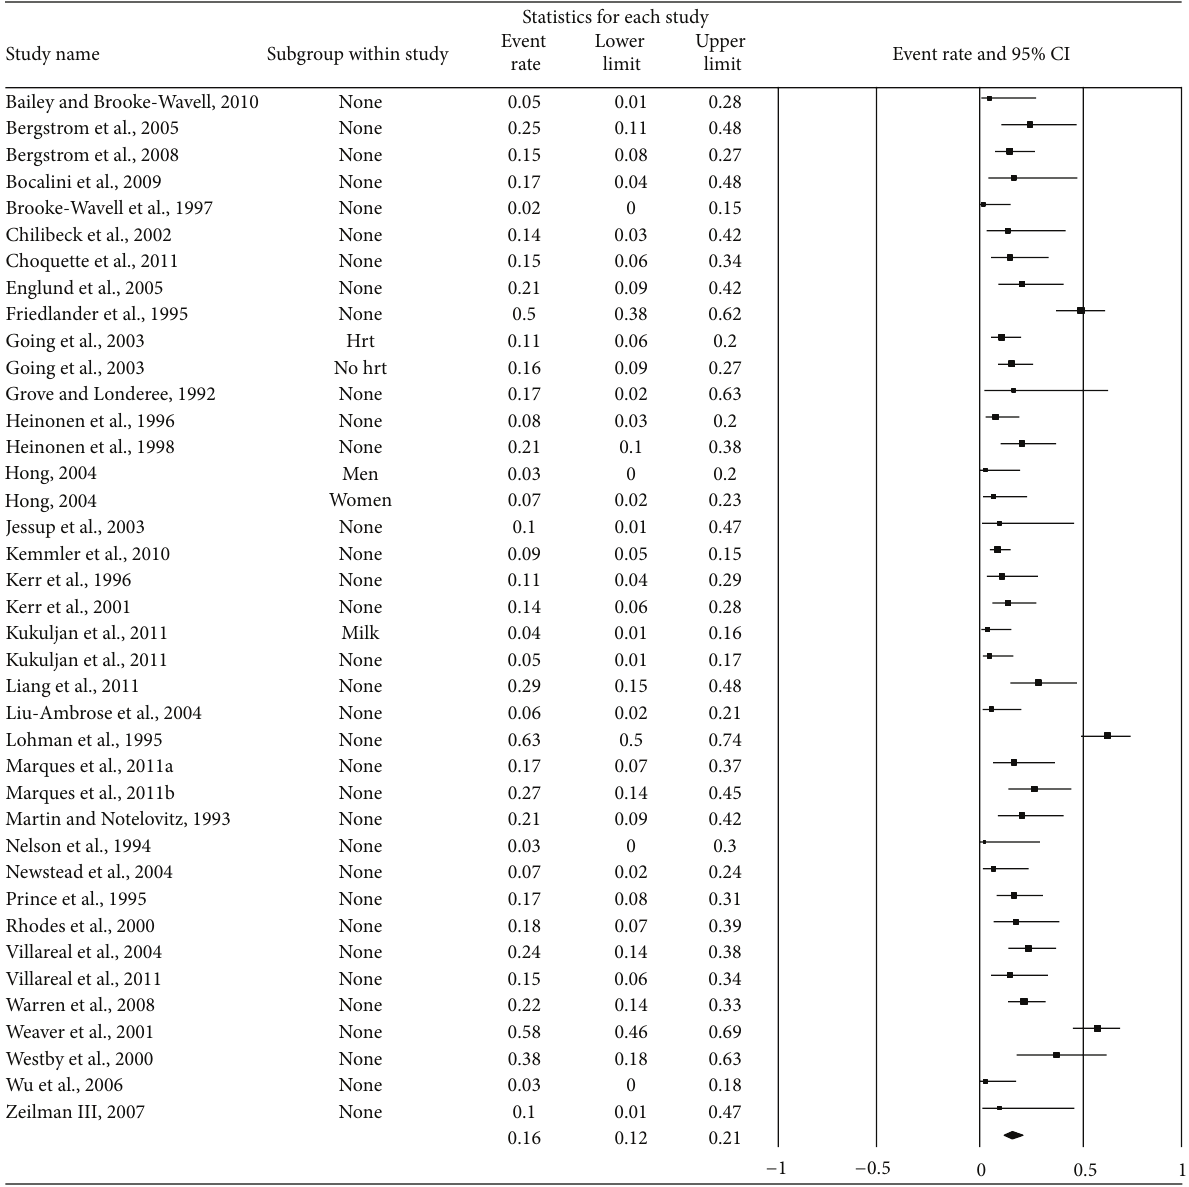
Figure 5: Forest plot for control dropouts (group level). Forest plot for control dropouts at the group level. The black squares represent the mean event rate while the left and right extremes of the squares represent the corresponding 95% confidence intervals. The middle of the black diamond represents the overall mean event rate while the left and right extremes of the diamond represent the corresponding 95% confidence